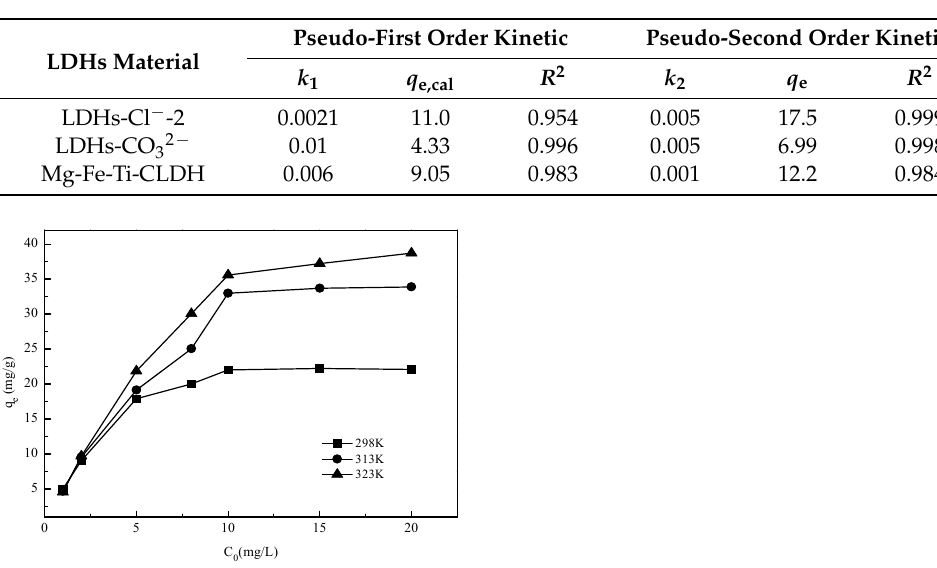
Figure 9. Effect of temperature on vanadate adsorption onto Mg-Fe-Ti-CLDH (experimental condi- tions: C 0 = 1–20 mg/L, adsorbent dosage = 10 mg, pH = 5.0, contact time = 24 h, T = 298–323 K). R: the gas constant 8.314 J/mol · K; K L (L/mol): the Langmuir constant; T (K): the absolute temperature.